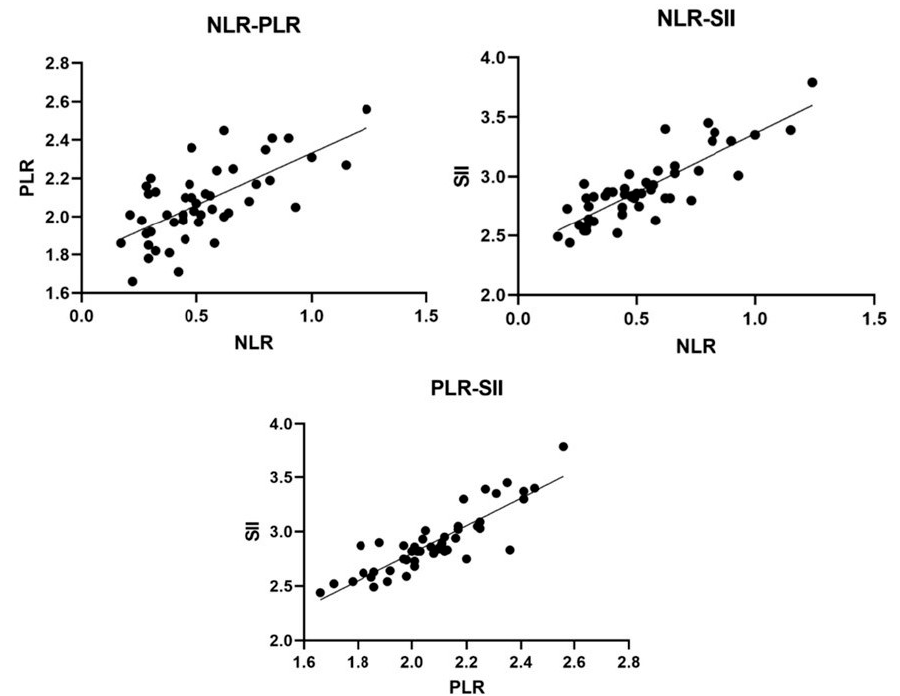
Figure 4. Correlation among the three inflammatory markers. NLR, neutrophil–lymphocyte ratio; PLR, platelet-to-lymphocyte ratio; SII, systemic immune-inflammation index.